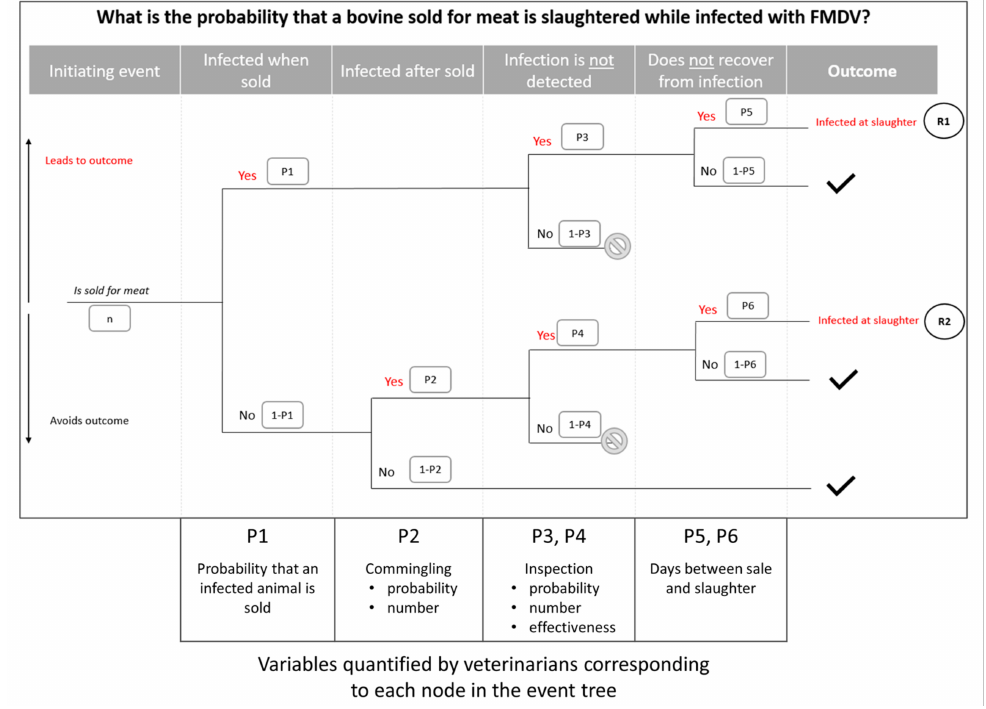
Figure 2. Event tree with risk pathways and variables characterized by veterinarians in Kenya and